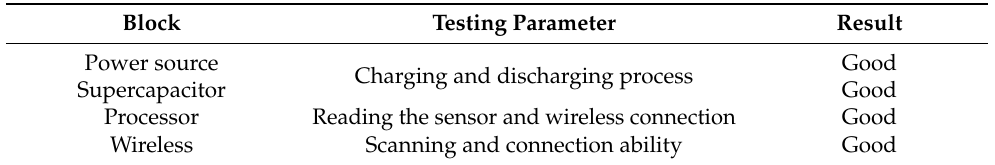
Table 3. Functionality test results.